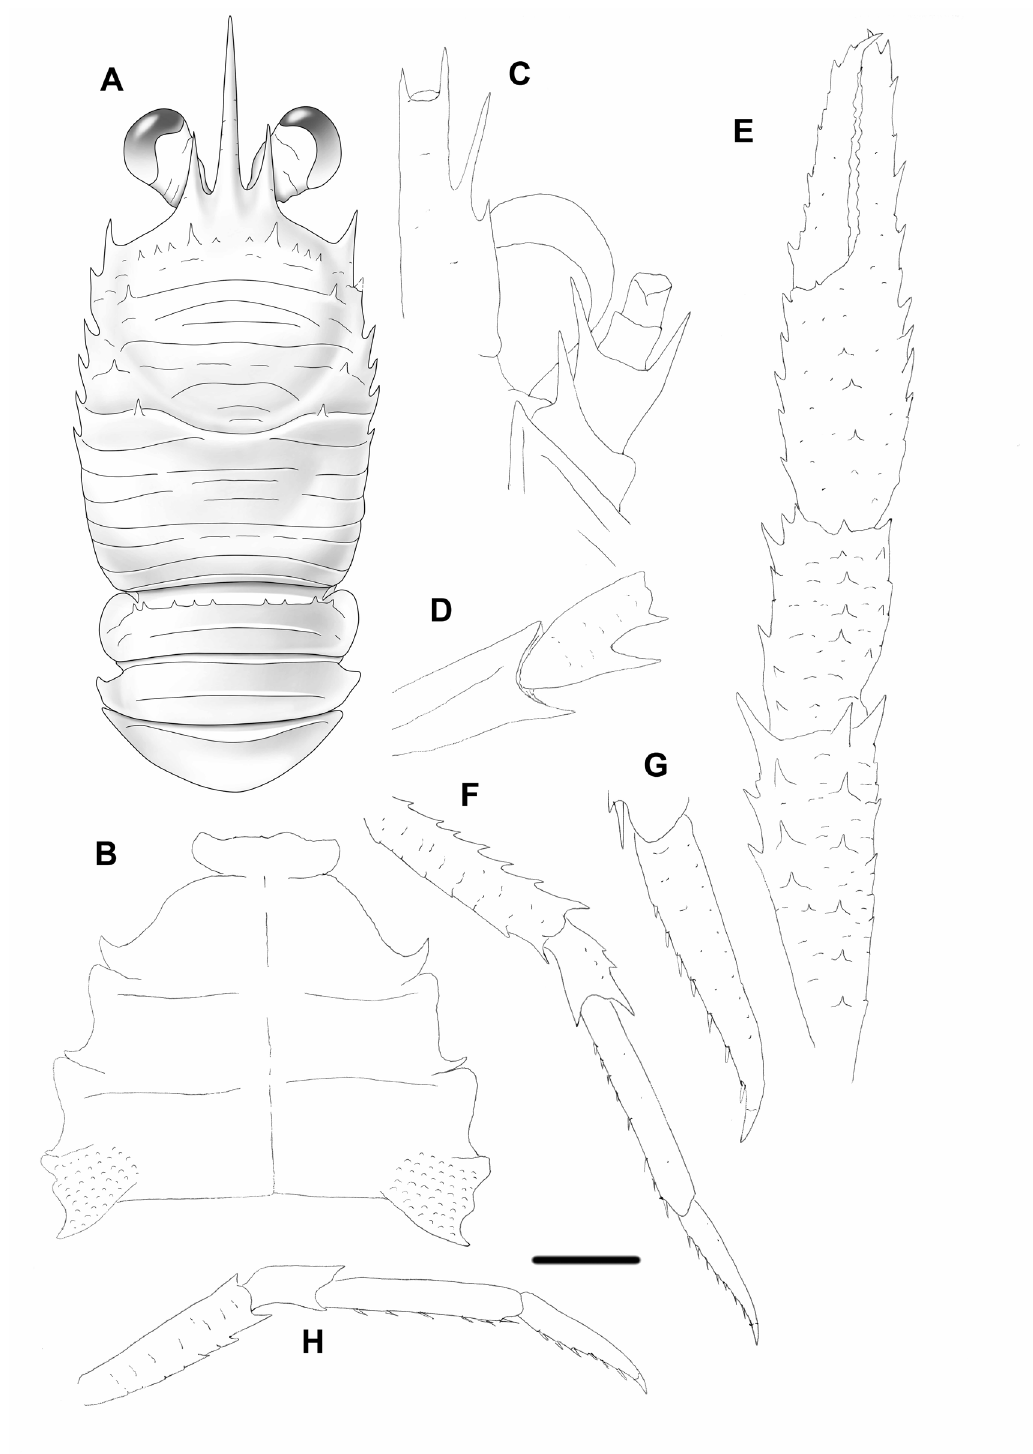
Fig. 9. Munida tetracantha sp. nov., holotype, ♂, 6.6 mm (MNHN-IU-2014-13474), Madagascar. A . Carapace and abdomen, dorsal view. B . Sternal plastron. C . Cephalic region, showing antennular and antennal peduncles, ventral view. D . Right Mxp3, lateral view. E . Right P1, dorsal view. F . Right P2, lateral view. G . Dactylus of right P2, lateral view. H . Right P4, lateral view. Scale bar: A, E–F, H = 2.0 mm; B–D, G = 1.0